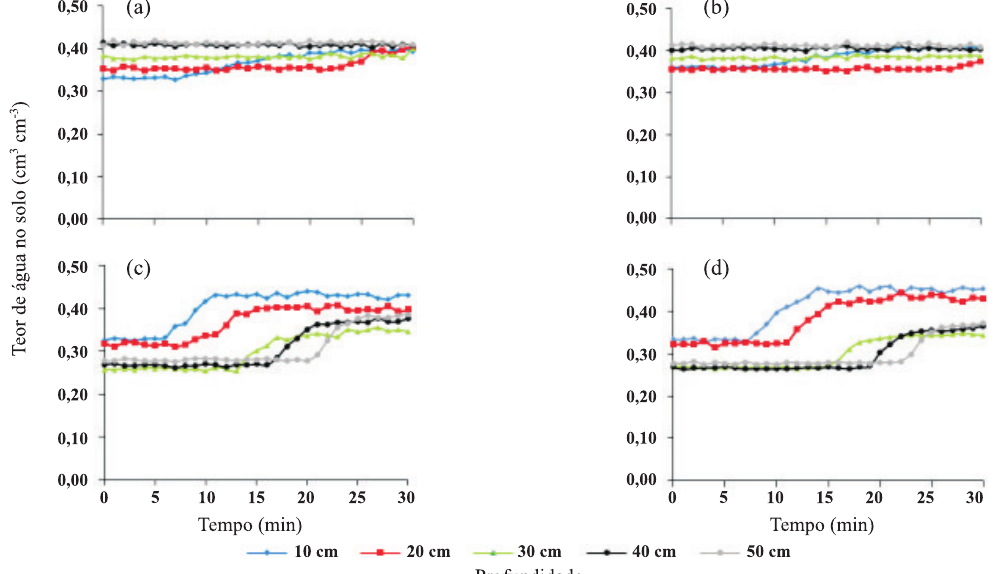
figura 5. variação no teor de água no solo com a profundidade e no tempo durante os ensaios de infiltra- ção com perfil de precipitação pluvial constante em solo sem cobertura – 2ª (a) e 3ª aplicações (b) – e em solo com cobertura – 2ª (c) e 3ª (d)